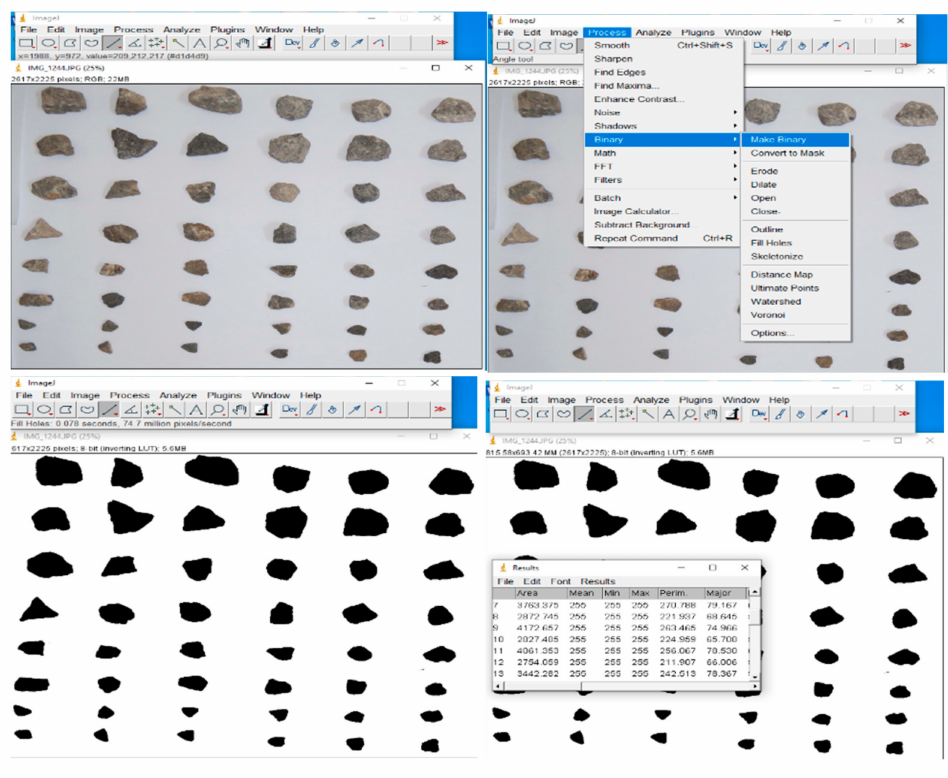
Figure 3. Step wise aggregates image